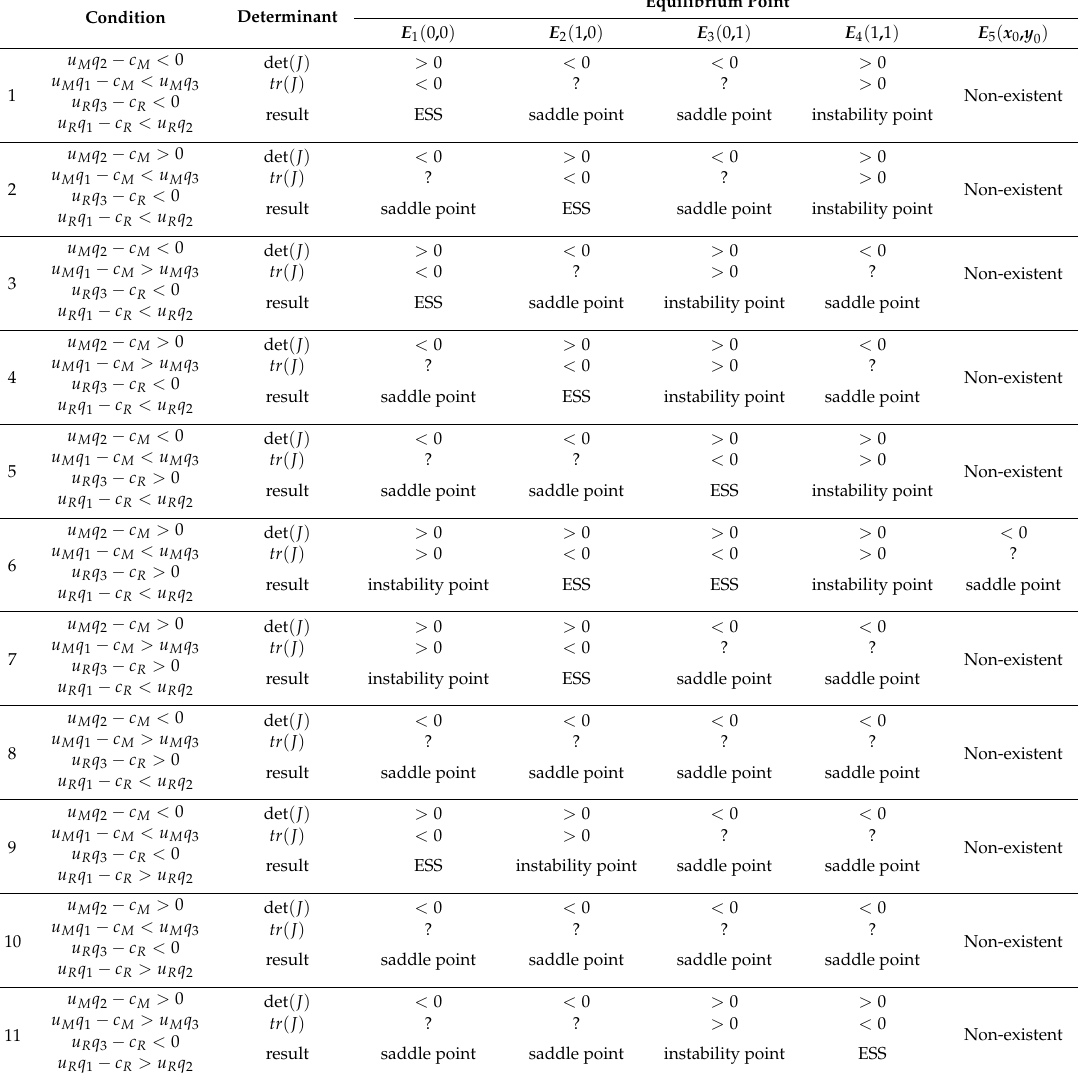
Table A2. Analysis of evolutionary stability of equilibrium